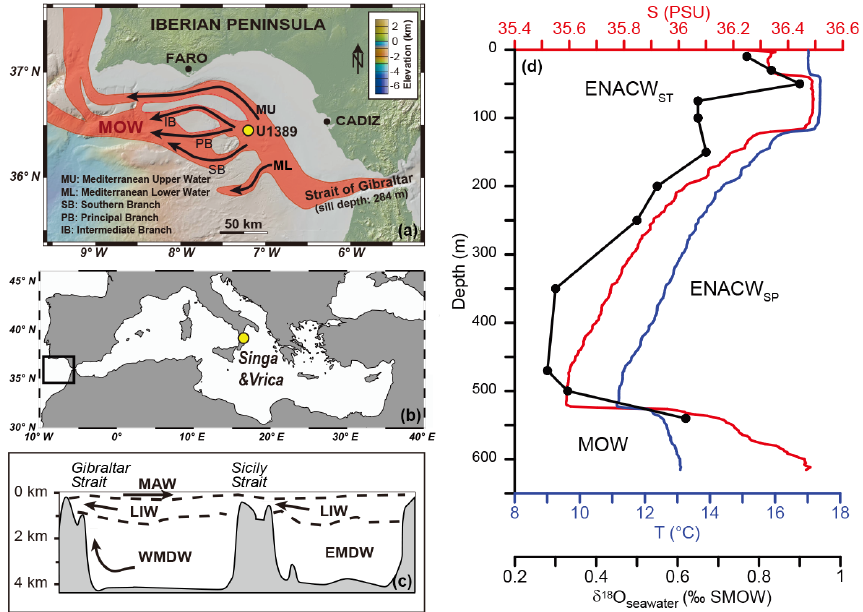
Figure 1. (a) Study area with illustration of modern MOW pathways modified after (Bahr et al., 2015). Site location of U1389 (yellow dot) is marked. (b) Overview map of the Mediterranean Sea. Location of the Singa and Vrica sections in Italy (yellow dot) are marked. Black square indicates Gulf of Cadiz study area. (c) Water mass circulation in the Mediterranean Sea (modified after Cramp and O’Sullivan, 1999). MAW: mixed Atlantic surface water; LIW: Levantine Intermediate Water; EMDW: Eastern Mediterranean Deep Water; WMDW: Western Mediterranean Deep Water. (d) CTD depth profile of temperature (red line) and salinity (blue line) at Site U1389 derived from the World Ocean Database 2013. The data points of δ 18 O water (black line) are derived from neighbouring EUROFLEETS Iberian-Forams cruise site IB-F9 (36 ◦ 48.40 (cid:48) N, 7 ◦ 42.85 (cid:48) W) (Voelker et al., 2015). NACW st : North Atlantic Central Water of subtropical origin; NACW sp : North Atlantic Water of subpolar origin; MOW: Mediterranean Outflow